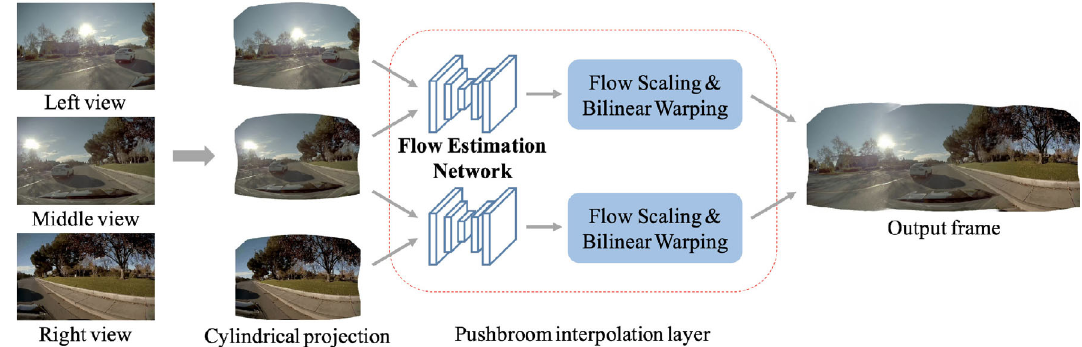
Fig. 2 Video stitching for linear camera arrays using CNNs with a pushbroom interpolation layer. Reproduced with permission from Ref. [22], c (cid:2) The British Machine Vision Association 2019.